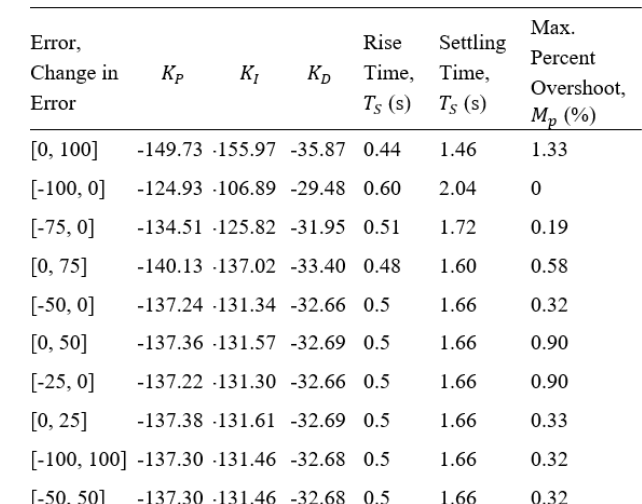
Fig. 13. Step Response of PID controller